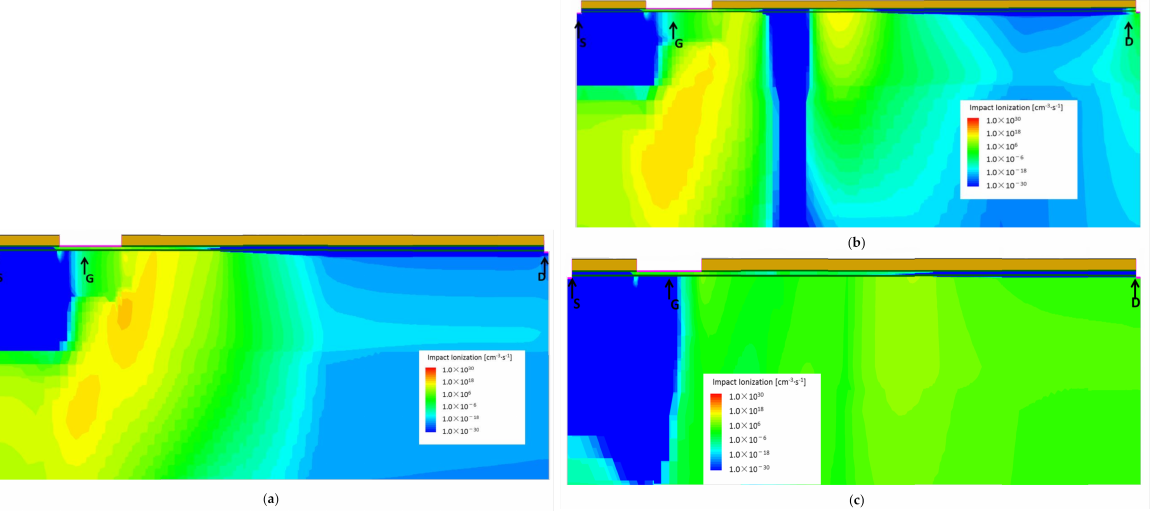
Figure 11. The cross-sections of the impact ionization after the heavy-ion striking at P5: ( a ) before heavy-ion striking, ( b ) 0.05 ns after heavy-ion striking, and ( c ) 50 ns after heavy-ion striking.